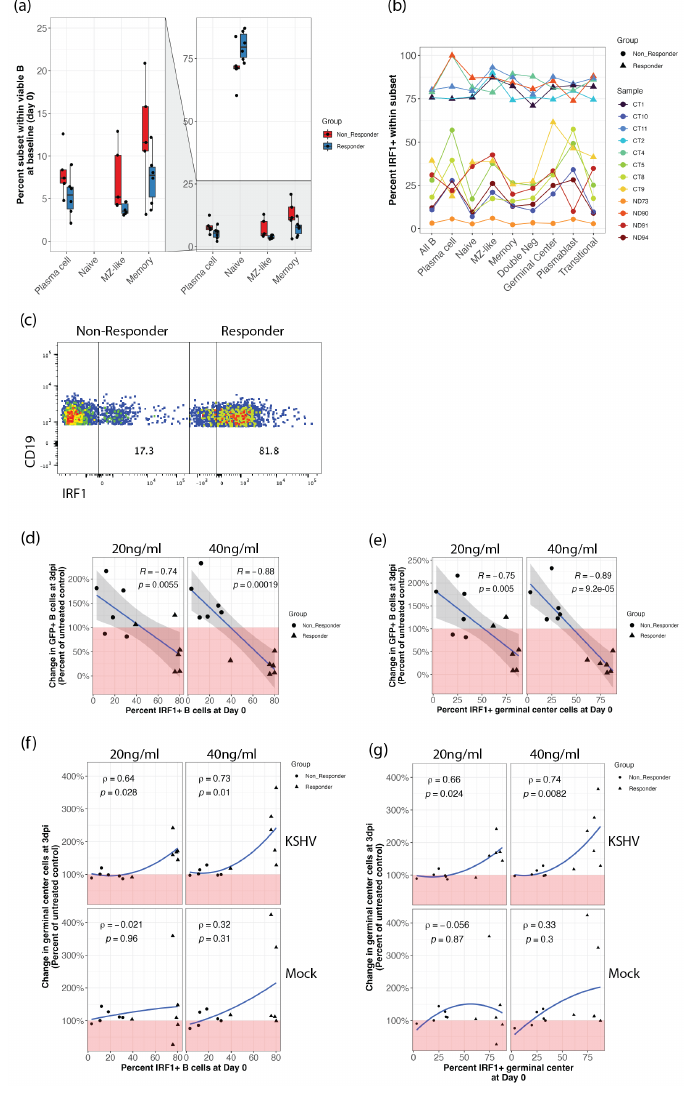
Figure 3. IFN- γ responsive specimens have higher baseline levels of immature and IRF1+ B cells. Tonsil-derived lymphocytes used in infection experiments in Figures 1 and 2 were analyzed by flow cytometry at day 0 for B cell immunophenotypes and IRF1 expression. ( a ) distribution of B cell subset frequencies within viable CD19+ comparing responder (blue) and non-responder (red) groups Wilcoxon test p < 0.01 and effect size > 0.5 for all subsets shown ( b ) percent IRF1+ cells within B cell subsets ( x -axis) for each sample (indicated by point and line color) classified based on IFN- γ responders (triangles) and non-responders (circles) shown in Figure 1c. Wilcoxon test comparing responders to non-responders p << 0.001 and effect size > 0.6 for all B cell subsets. ( c ) representative flow cytometry data showing baseline IRF1 expression within viable, CD19+ cells from a non-responder and responder samples. Pearson correlations between the effect of IFN- γ doses on KSHV infection at 3 dpi and ( d ) IRF1 expression in all B cells or ( e ) IRF1 expression in GCB at day 0. Spearman correlations between the effect of IFN- γ doses on GCB frequency in mock infected (bottom) and KSHV-infected (top) cultures at 3 dpi and ( f ) IRF1 expression in all B cells or ( g ) IRF1 expression in GCB at day